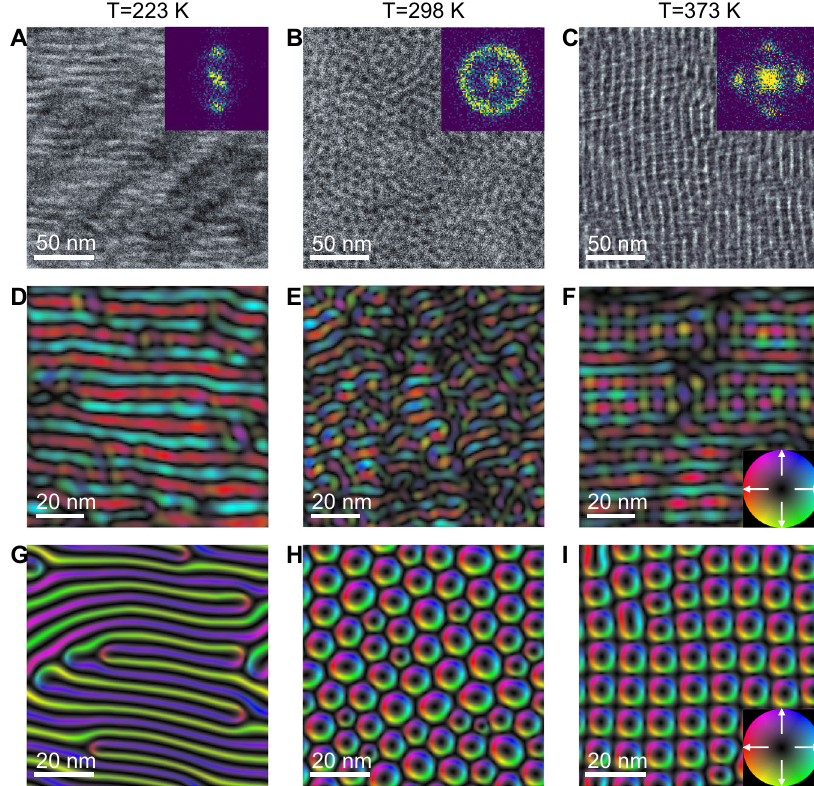
Fig. 3 | Variations of polar textures with temperature. Plan-view dark fi eld STEM imaging of [(SrTiO 3 ) 16 /(PbTiO 3 ) 16 ] 8 superlattice acquired with tem- peratures at ( A ) 223K, ( B ) 298K, and ( C ) 373K. Insets, fast Fourier transform (FFT) of the images in A – C showing different types of ordering. Polarization maps reconstructed from the 4D-STEM dataset of superlattice at ( D ) 223K, ( E ) 298K, and ( F ) 373K, showing the in-plane Bloch components of polar- skyrmions. D – F are acquired from nearby regions of A – C . The corresponding phase- fi eld simulations with temperatures and in-plane lattice parameters